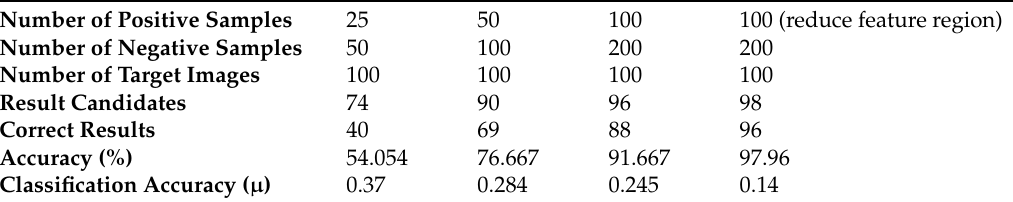
Table 1. Experiment data of light spot positioning system.